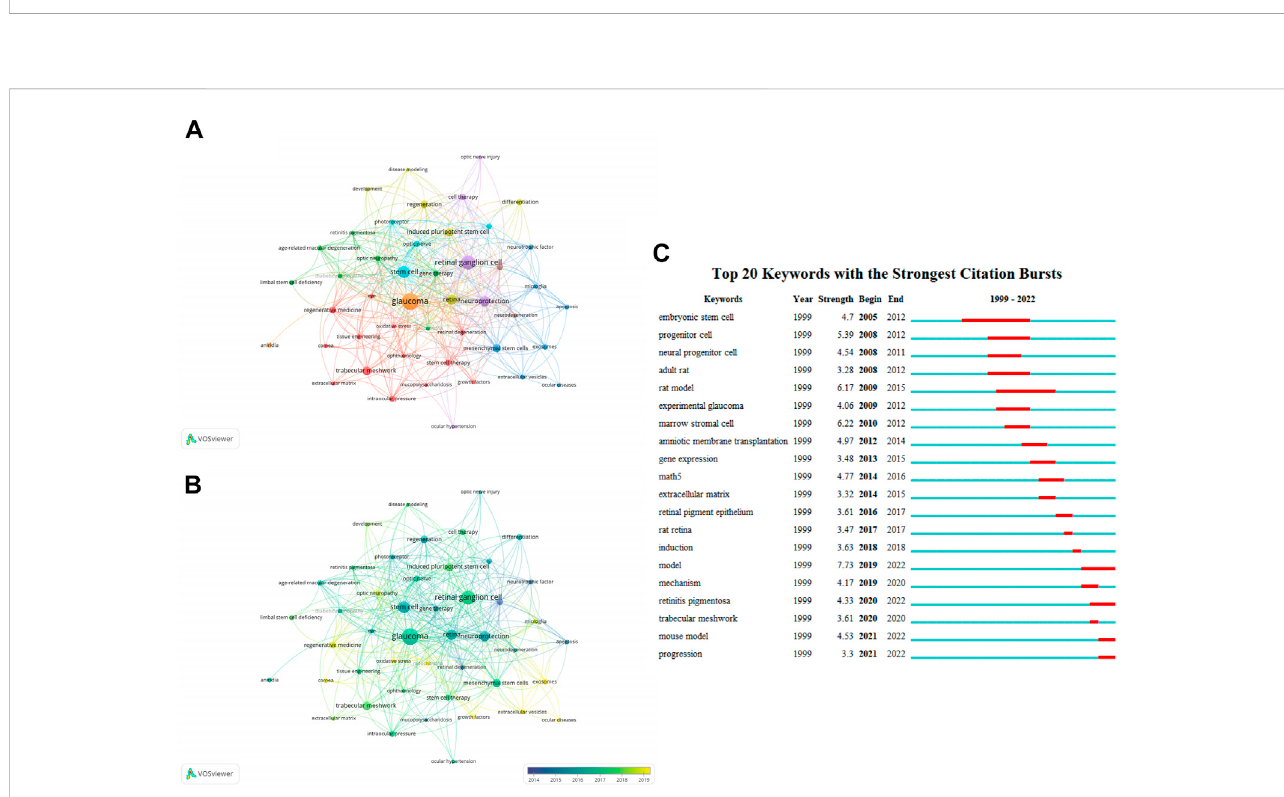
FIGURE 5 Analysis of keywords related to publications on applications of stem cells for glaucoma treatment and research. (A) The co-occurrence network visualization map of keywords related to the application of stem cells for glaucoma. The keywords were clustered into eight groups according to their colors. Large nodes represent keywords with high frequencies. (B) Keywords are colored according to their appearance for the average time. Blue represents the early stage, and yellow represents the late stage. (C) The top 20 keywords with the strongest citation bursts regarding applications of stem cells for glaucoma from 1999 through 2022. The red segment of the blue line denotes the burst duration of a